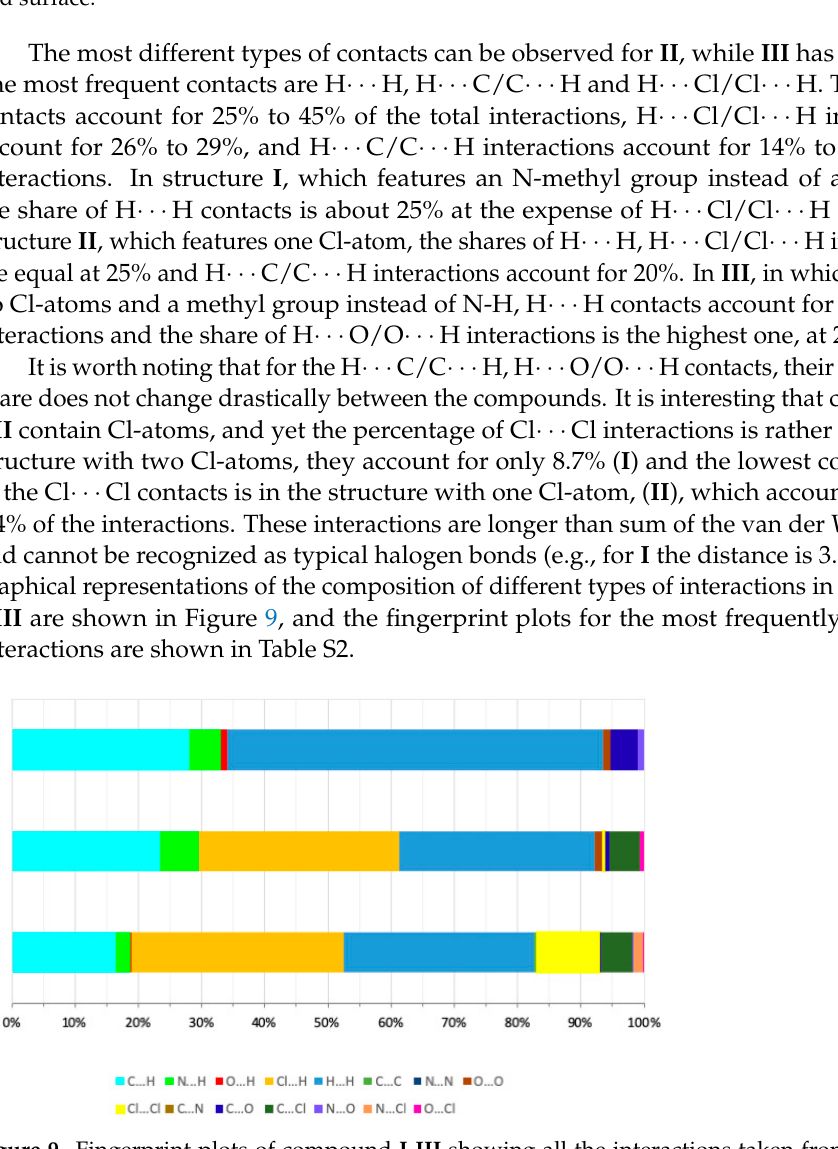
Figure 8. Fingerprint plots of compound I - III showing all the interactions taken from the Hirshfeld surface.